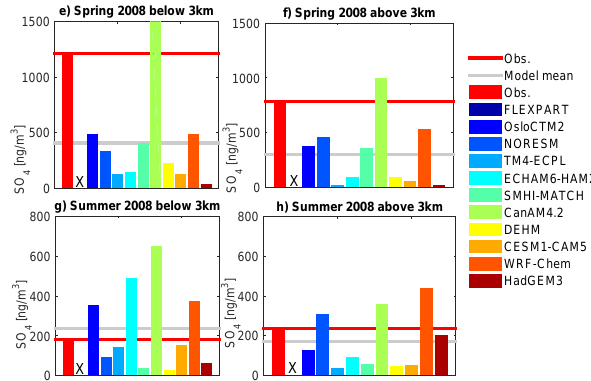
Figure 10. Median SO 4 concentrations for the ARCTAS/ARCPAC spring 2008 (a – b) and ARCTAS summer 2008 (c – d) campaigns. The red bar and the red horizontal line show the observations, the other colored bars the various models. The analysis is performed for measurements below 3km (left panels) and above 3km (right panels). Note: each row has a different y axis.